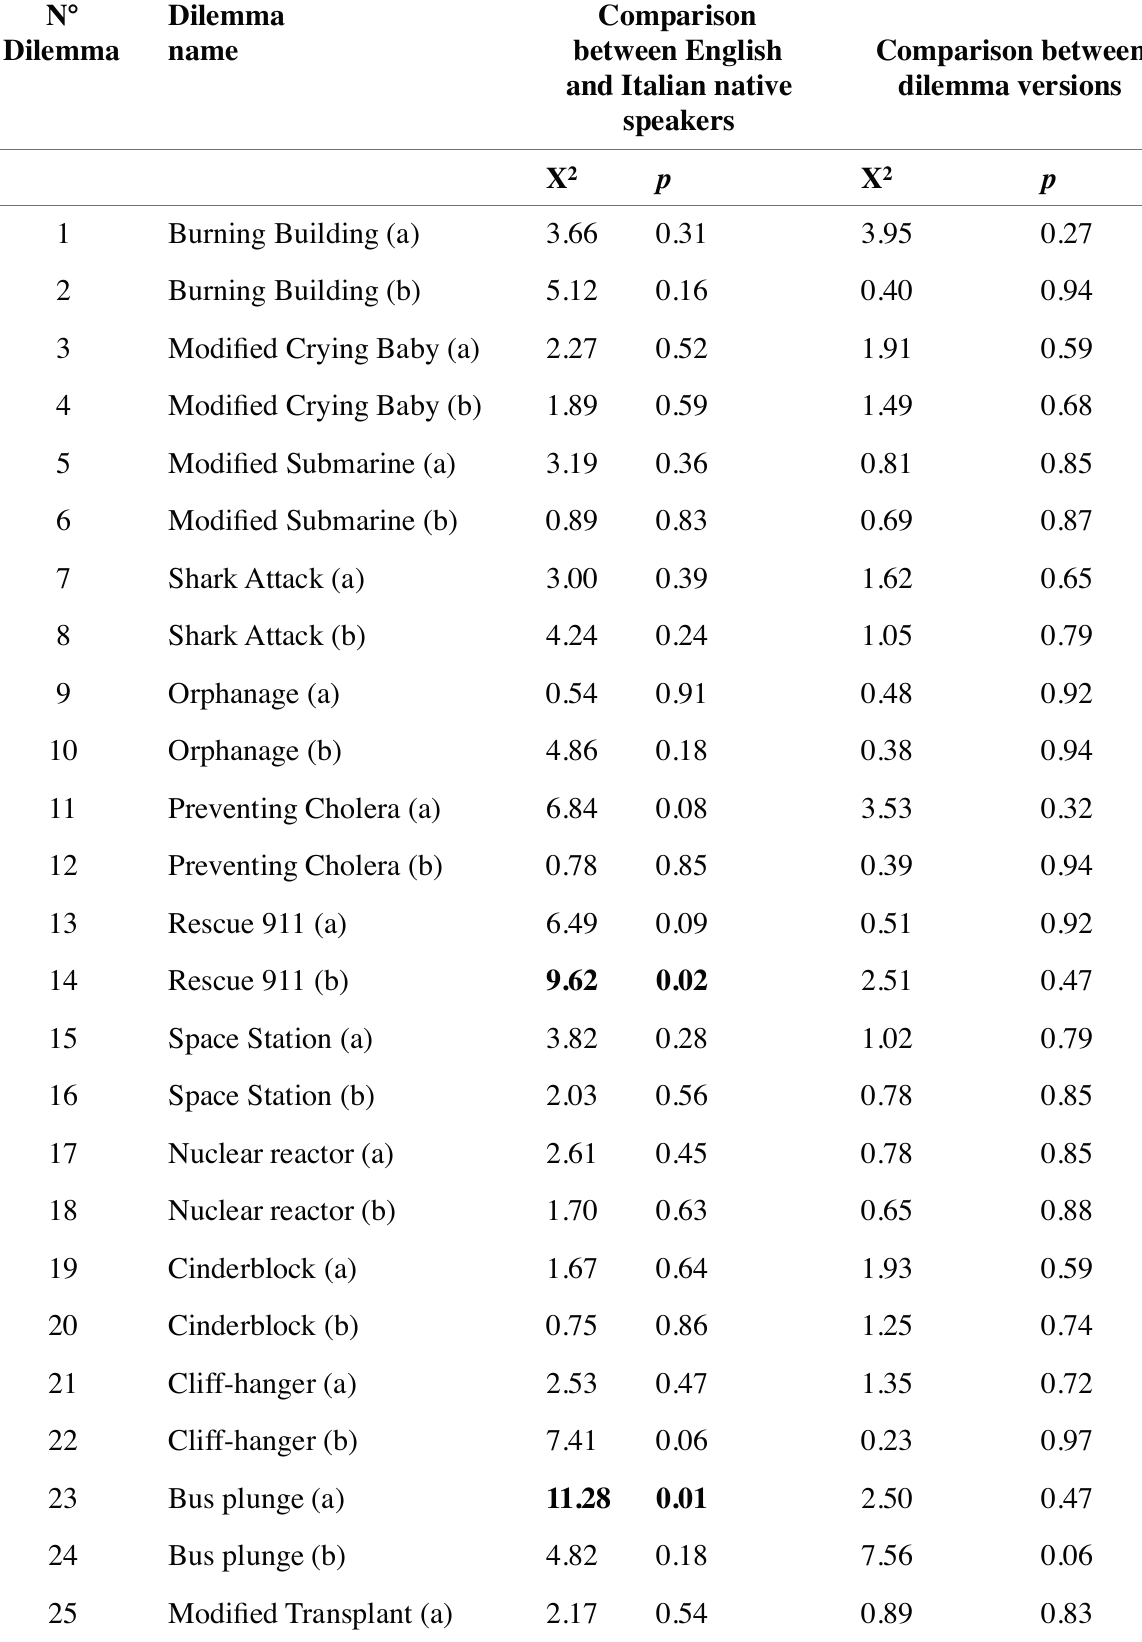
Table 2SI. Summary of Chi-square tests comparisons between English and Italian native speakers for each